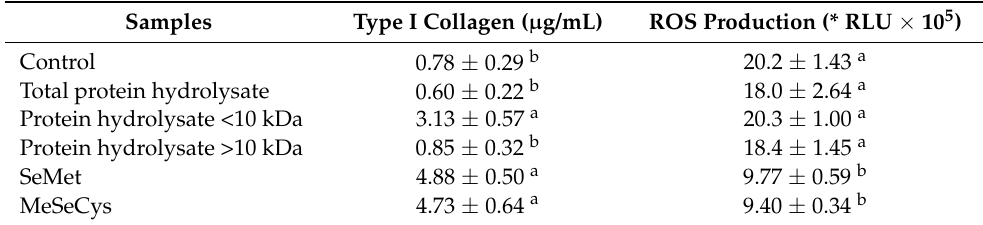
Table 4. Photoaging assay represented by the type I collagen concentration ( µ g/mL) and reactive oxygen species (ROS) production resulting from the preventive assay using selenized chickpea I collagen concentration. protein hydrolysates (3.125 µ g/mL) in HDFa cells 6 h before UVA radiation.